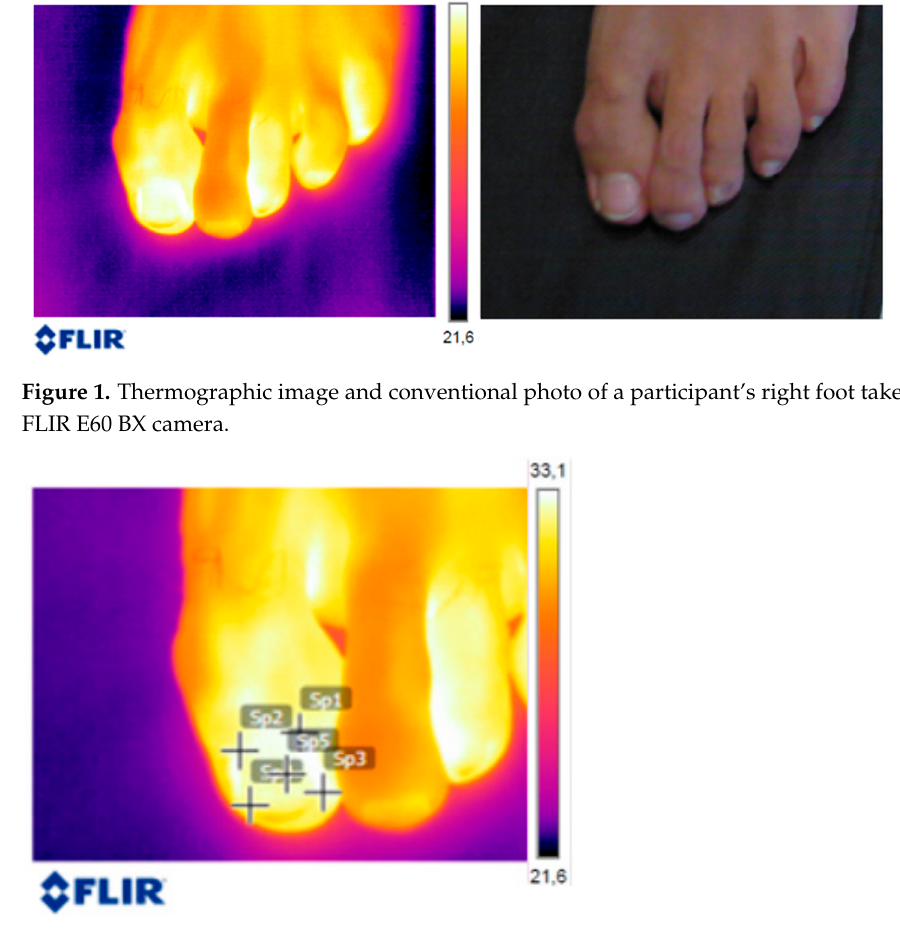
Figure 1. Thermographic image and conventional photo of a participant’s right foot taken with the FLIR E60 BX camera.